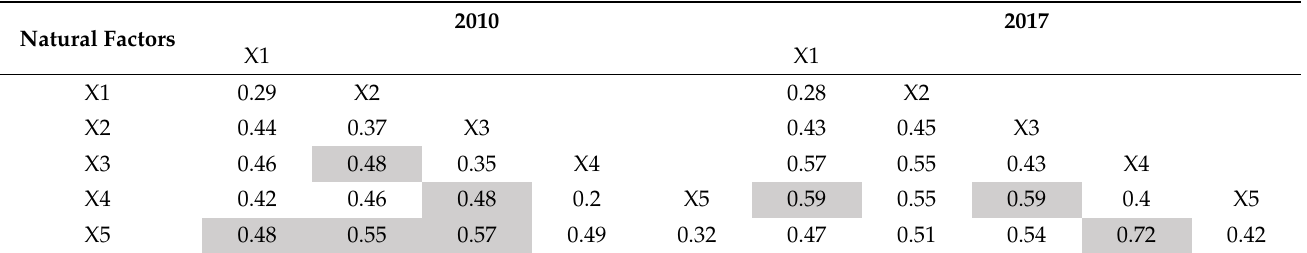
Table 4. Interaction effects of the natural environmental factors on PM 2.5Cement . The gray shaded items are the top three values in year. X1. . . 54 are the Natural factors found in Table 1. Natural Factors